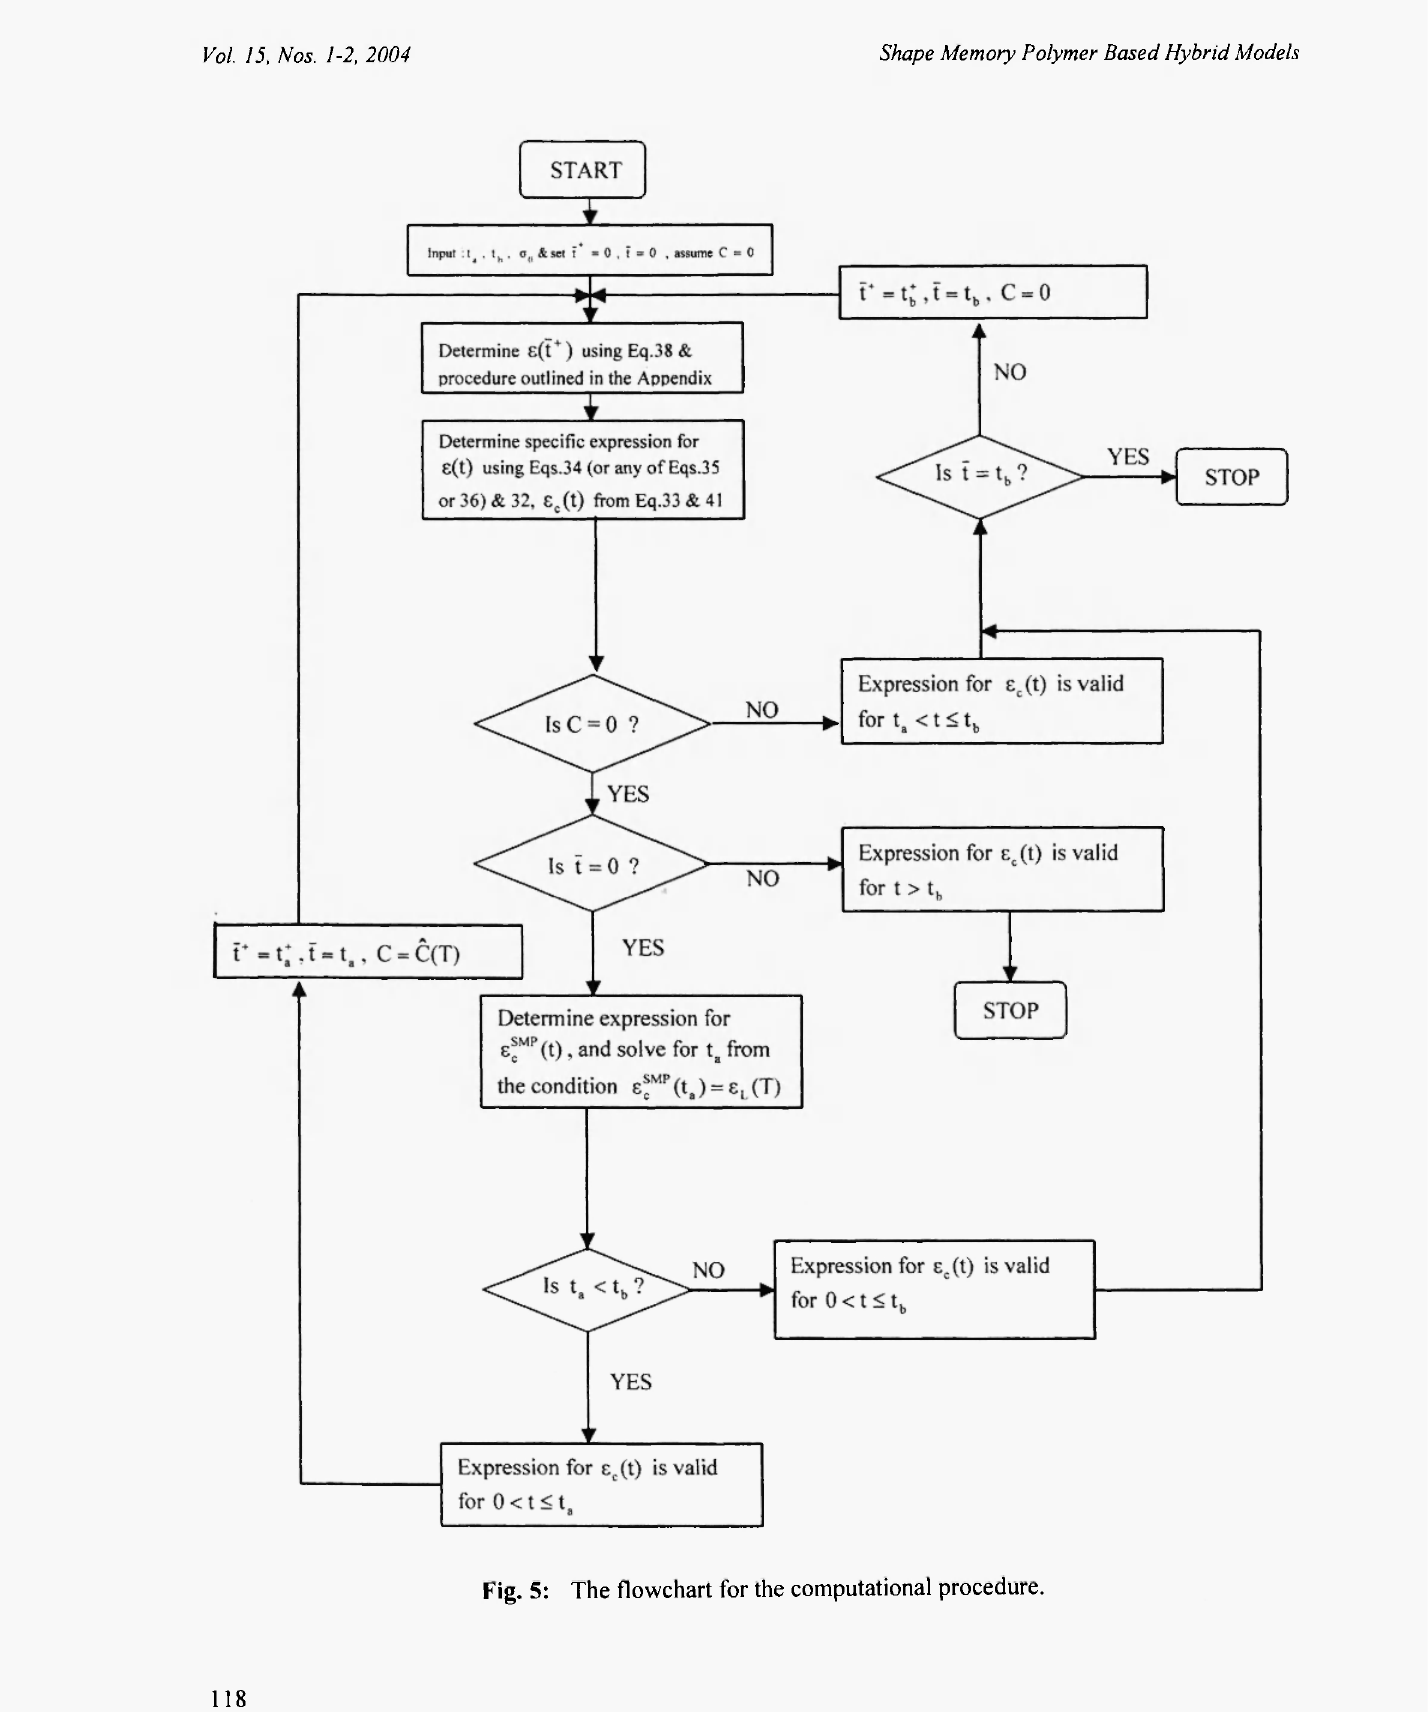
Fig. 5: The flowchart for the computational